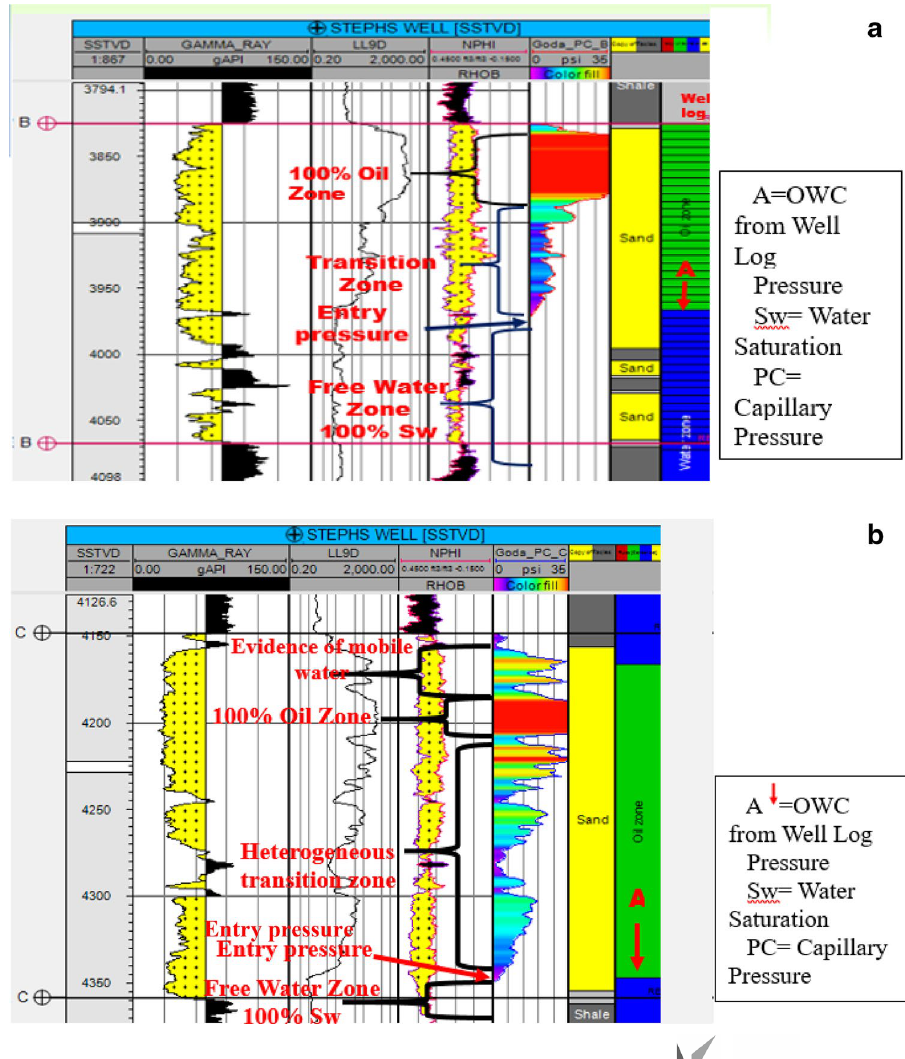
Fig. 6 a Well section for reservoir B showing empiri- cal capillary pressure log and delineated zones. b Well section for reservoir C showing empiri- cal capillary pressure log and delineated